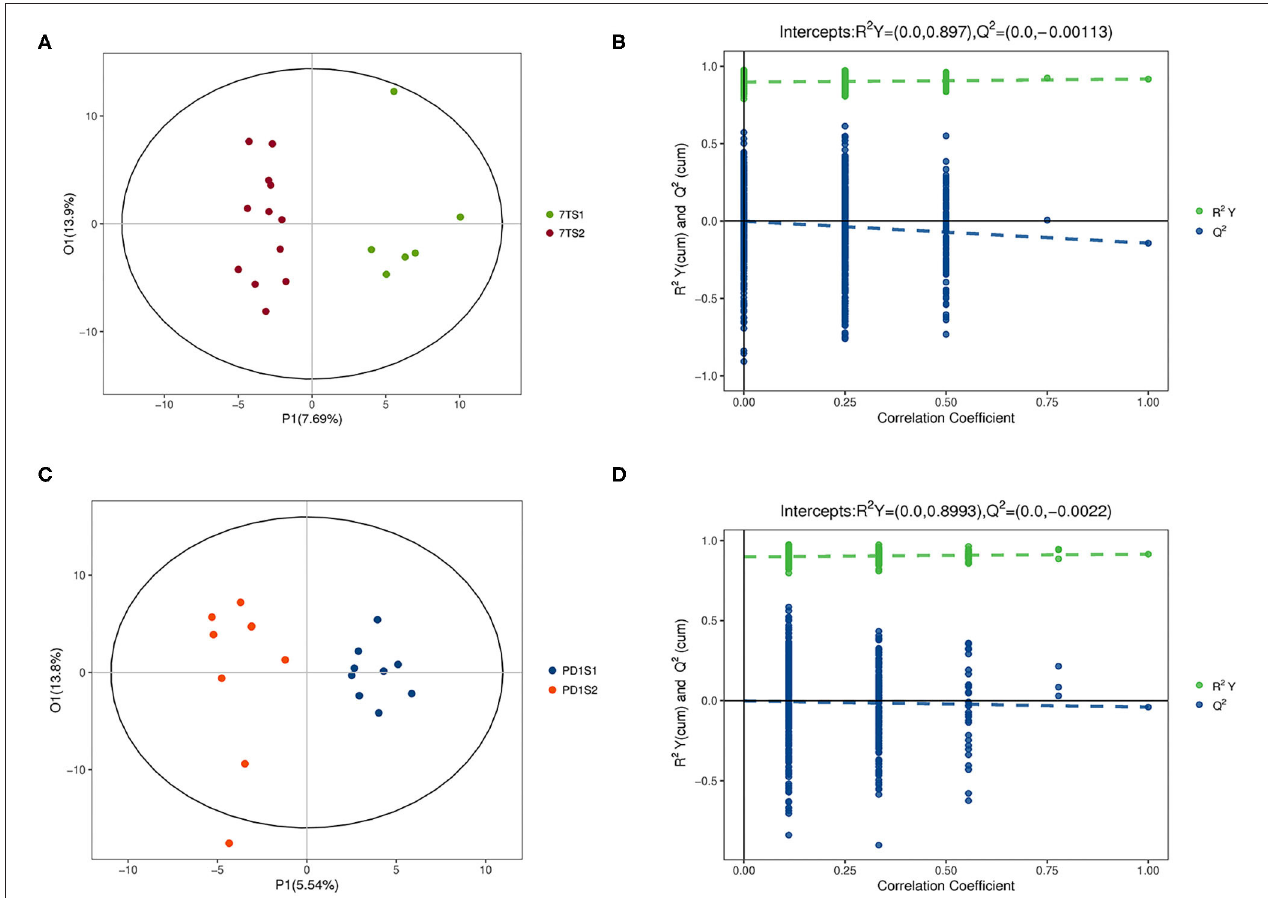
FIGURE 2 | The multidimensional results in positive ionization mode are shown in this figure. (A,B) Are from the 7-day prognosis group; (C,D) are from the PD-1 expression group. (A) OPLS-DA score plot: the 7TS1 group vs. the 7TS2 group. (B) OPLS-DA validation plot intercepts: the 7TS1 group vs. the 7TS2 group; R2Y = (0.0, 0.897), Q2 = (0.0, − 0.00113). (C) OPLS-DA score plot: the PDS1 group vs. the PDS2 group. (D) OPLS-DA validation plot intercepts: the PDS1 group vs. the PDS2 group; R2Y = (0.0, 0.8993), Q2 = (0.0, −